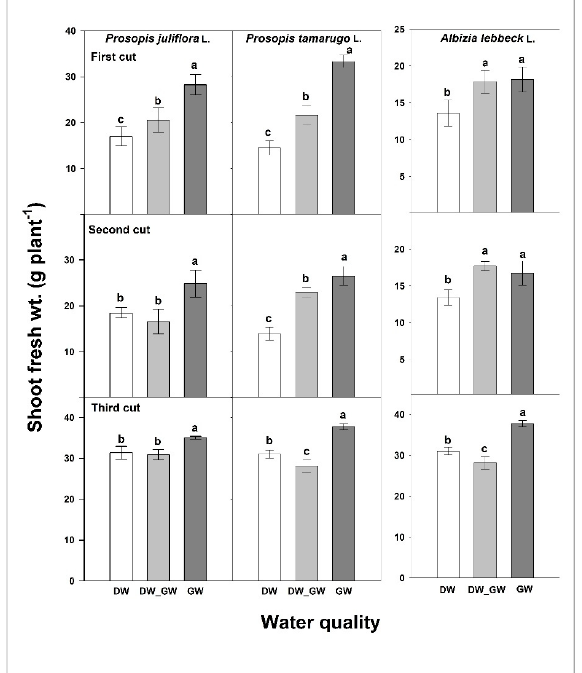
Figure 2. Fresh yield of different multipurpose tree species ( Prosopis juliflora L., P. tamarugo L., and Albizia lebbeck L.) grown under different water quality treatment; distilled water (DW), distilled + greywater (DW_GW), and greywater (GW). Bars represent mean ± standard error (SE). Different letters indicate a significant difference between treatments ( p ≤ 0.05). Horticulturae 2021 , 7 , x FOR PEER REVIEW